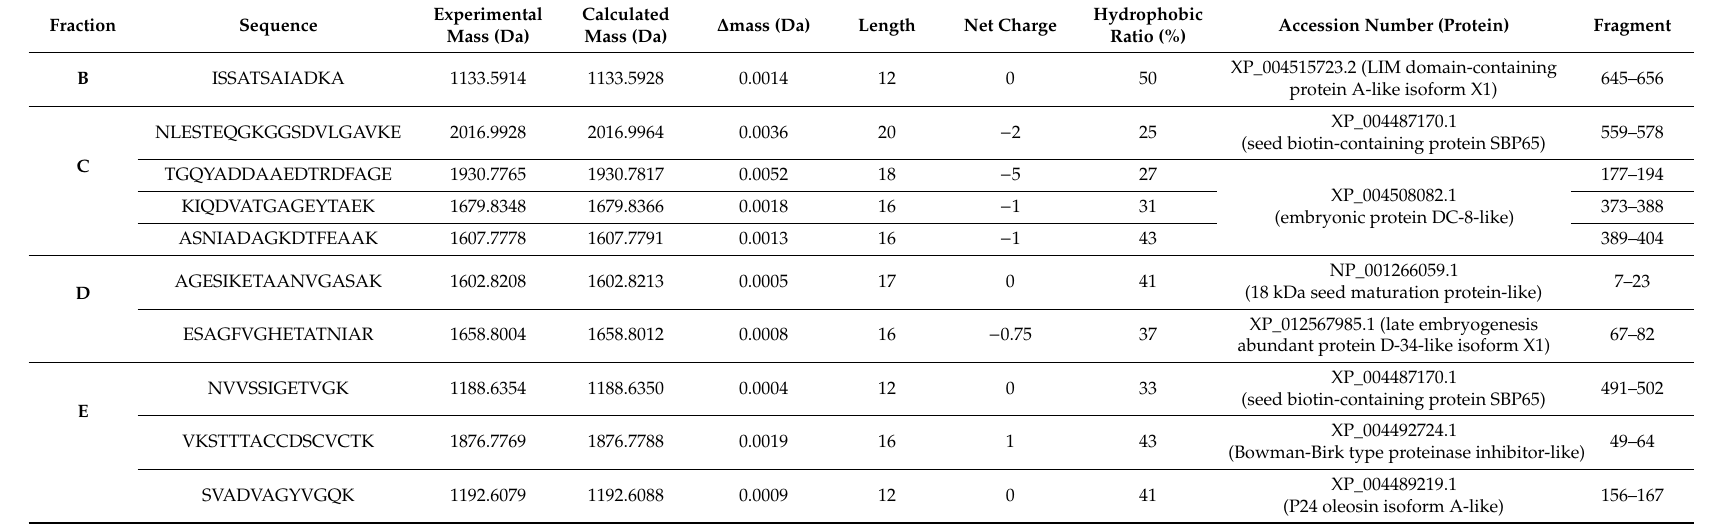
Table 3. List of peptides identified in partially purified peptide fractions obtained from the water / salt-soluble extract from chickpea sourdough through Reversed-Phase Fast Performance Liquid Chromatography